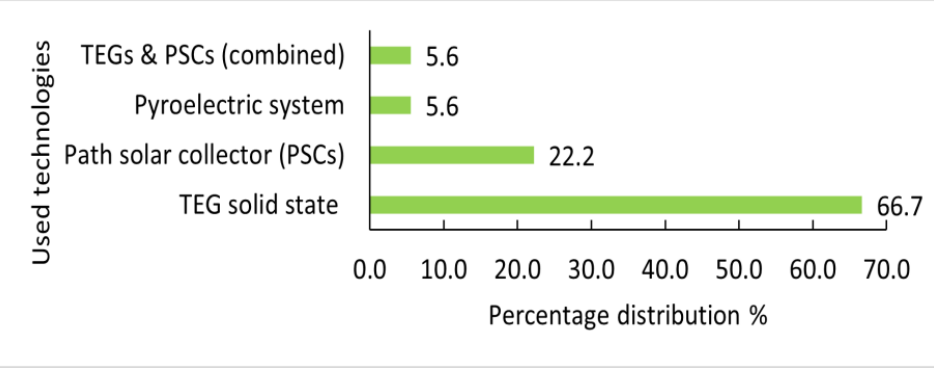
Figure 8. Publication distribution based on the used technique.